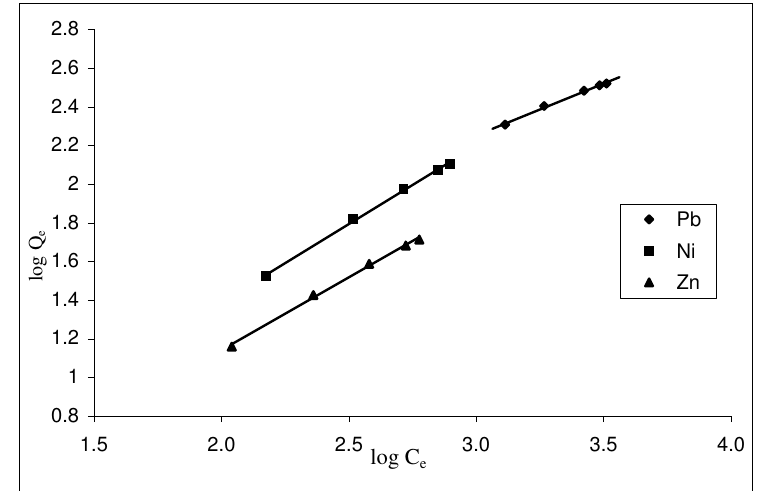
Figure 3 . Freundlich isotherm for the adsorption of Pb, Ni and Zn ions from aqueous solution by Helix aspera